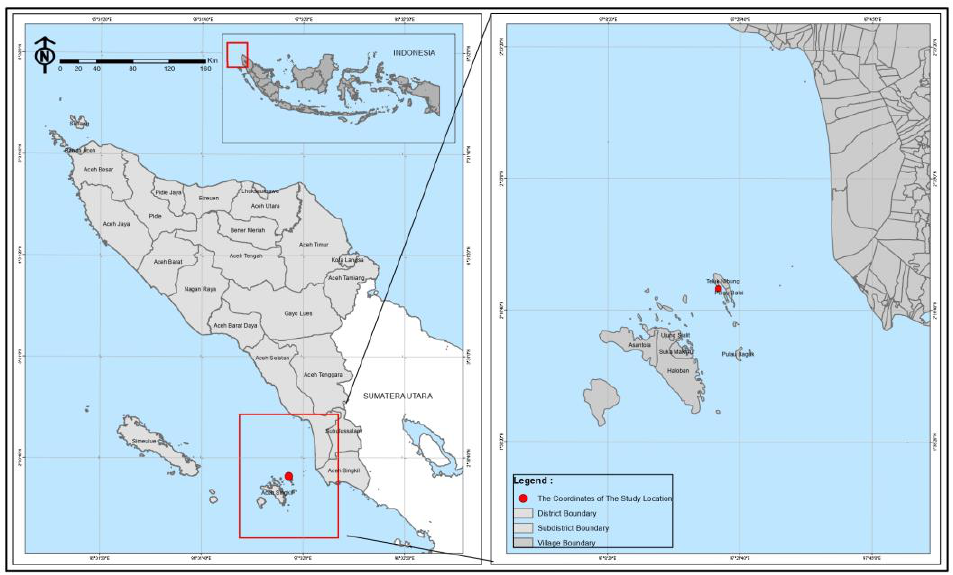
Figure 6. Sampling location Figure 6 . Sampling location map .